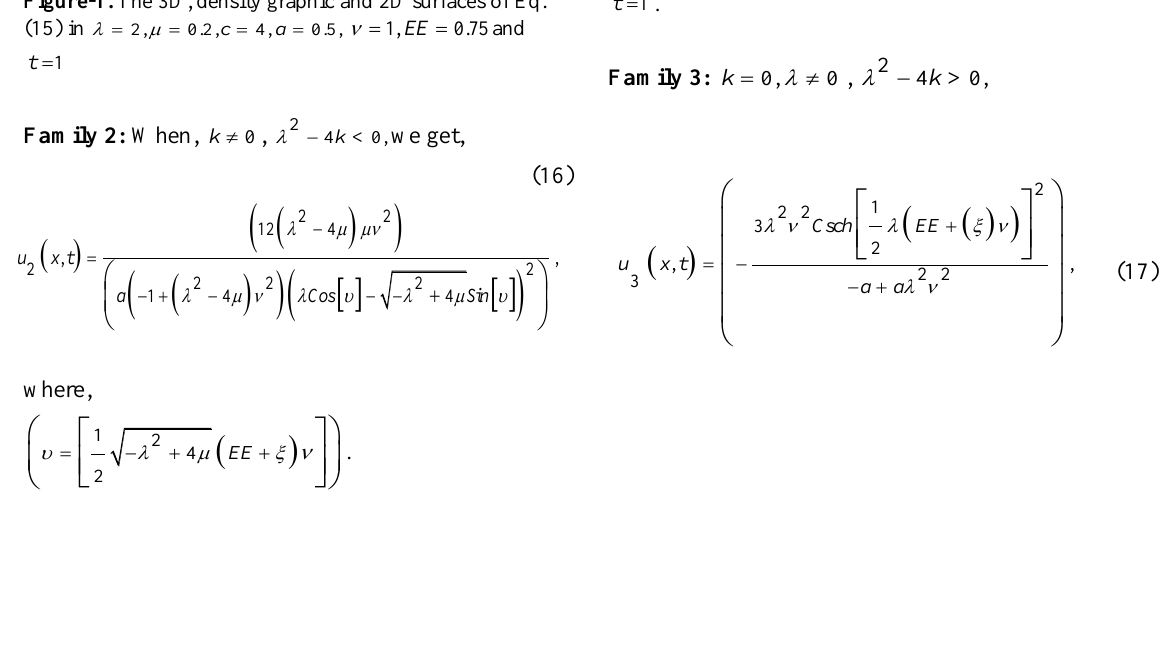
Figure-1. The 3D, density graphic and 2D surfaces of Eq.